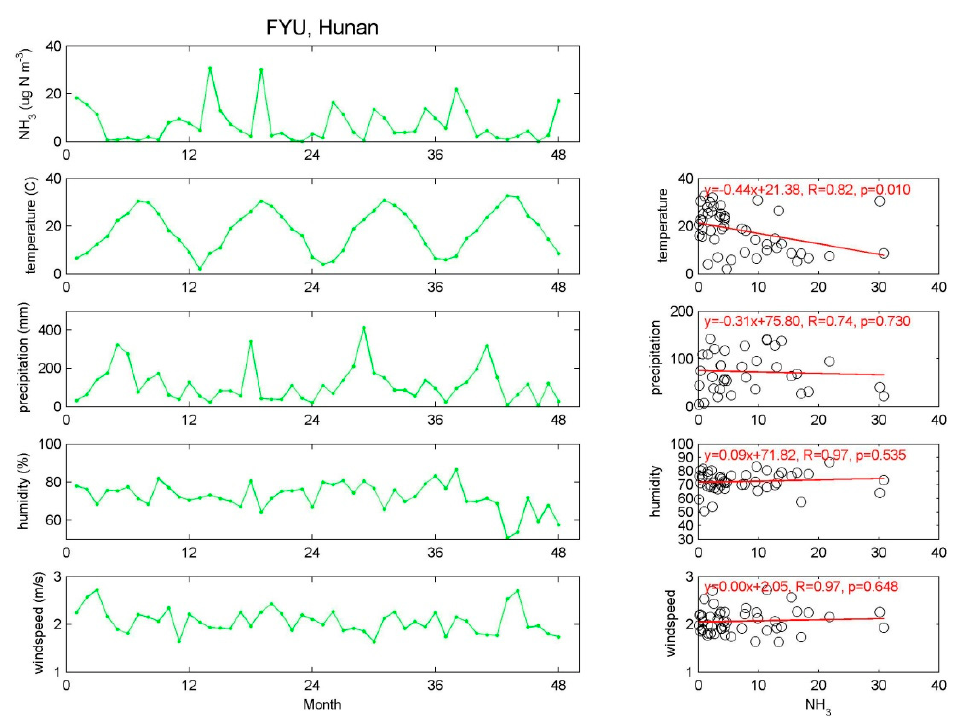
Figure A8. The seasonal variations of ground NH 3 concentrations ( µ g N m − 3 ), temperature ( ◦ C), precipitation (mm), humidity (%), and wind speed (m/s) at FYU from January 2010 to December 2013 (0–12, 2010; 13–24, 2011; 25–36, 2012; 37–48, 2013).